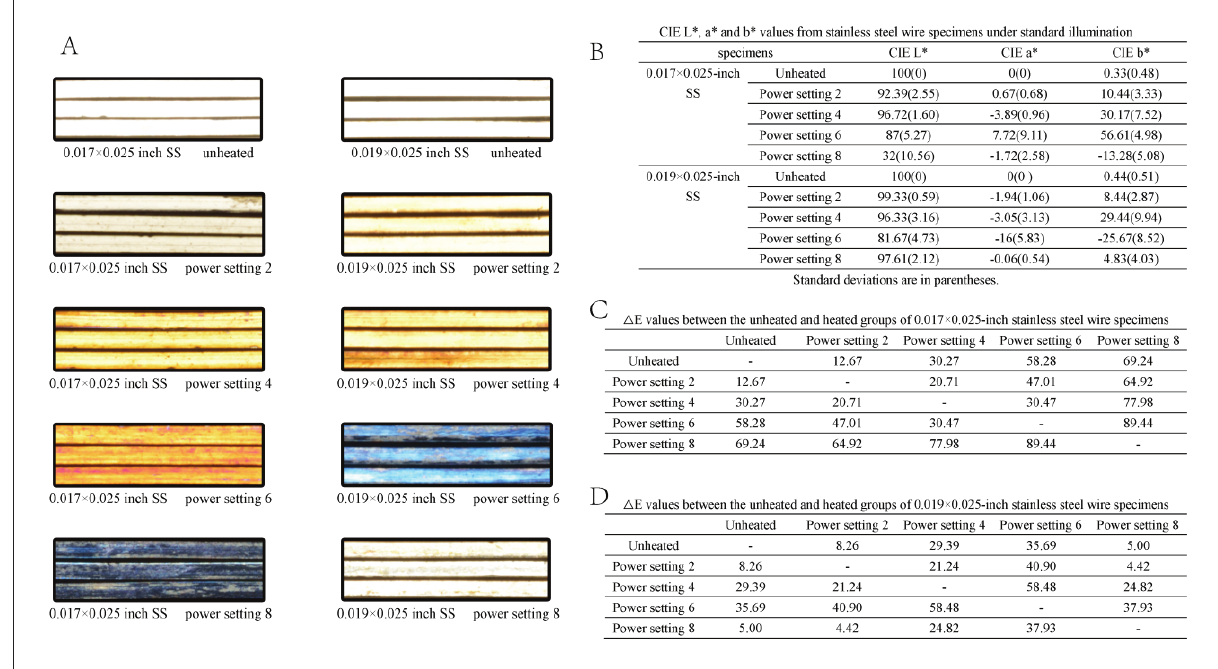
Figure 6. (A) Heat-induced changes in the colour of the 0.017 × 0.025 inch and 0.019 × 0.025 inch unheated SS wire specimens and specimens heated at power settings of 2, 4, 6, and 8 for eight seconds; images were captured using a digital SLR camera under standard illumination. (B) CIE L*, a*, and b* values of the 0.017 × 0.025 inch and 0.019 × 0.025 inch unheated SS wire specimens and specimens heated at power settings of 2, 4, 6, and 8 for eight seconds under standard illumination. (C) △ E values (colour difference) between any two groups of unheated and heated 0.017 × 0.025 inch SS wire specimens. (D) △ E values (colour difference) between any two groups of unheated and heated 0.019 × 0.025-inch SS wire specimens.